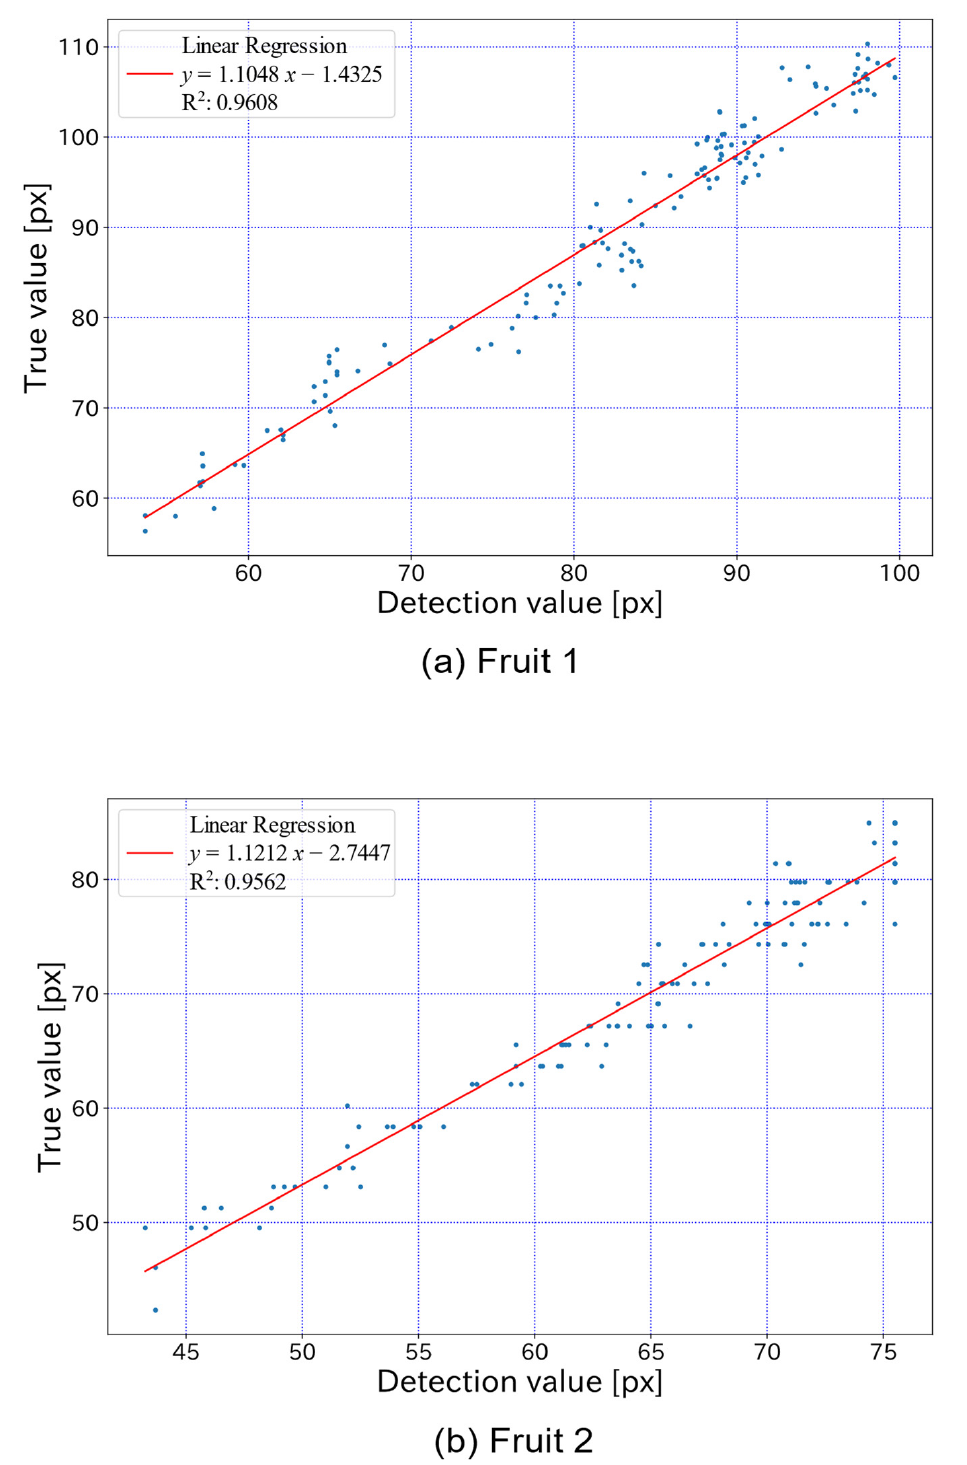
Figure 14. True values vs. detected values for the same elapsed days. The MAPE is 0.079 for Fruit 1 and 0.072 for Fruit 2, while the coefficient of determination for linear regression is approximately 0.96 for both Fruit 1 and Fruit 2.